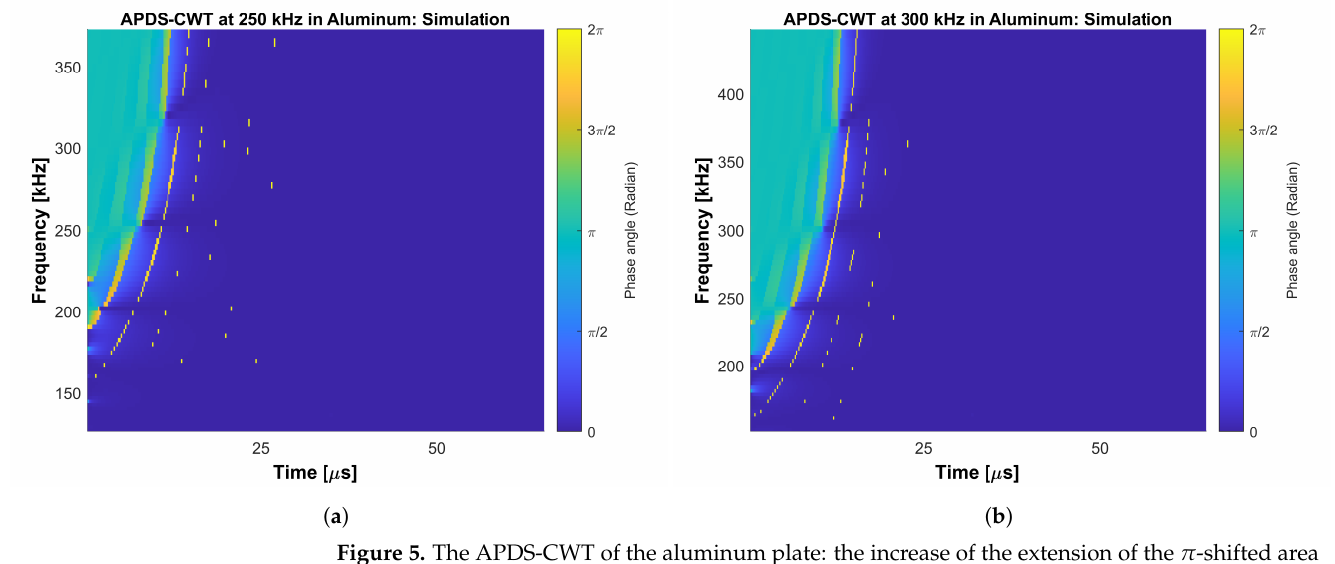
Figure 5. The APDS-CWT of the aluminum plate: the increase of the extension of the π -shifted area with increase of the time signal center frequency can be identified. ( a ) APDS-CWT of the Aluminum plate at 250kHz. ( b ) APDS-CWT of the Aluminum plate at